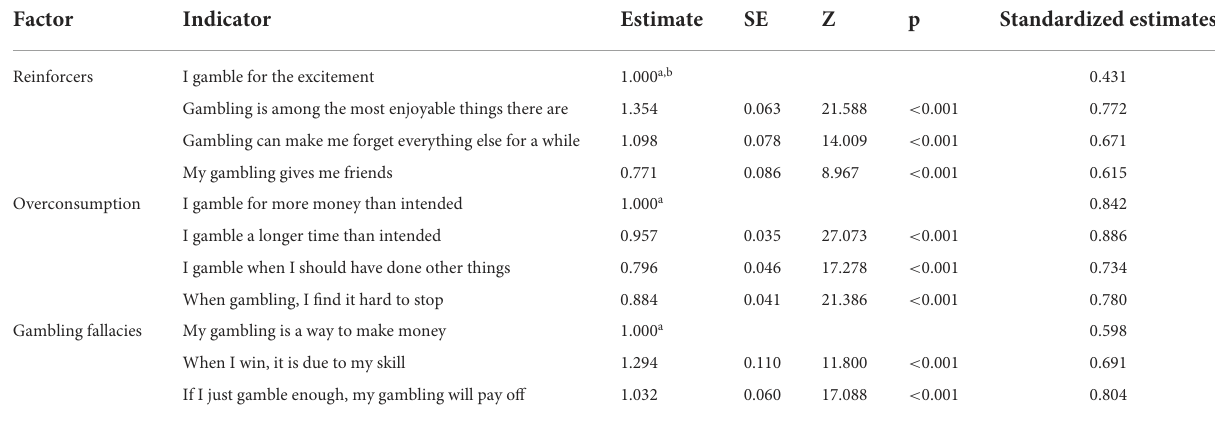
TABLE 1 Factor loadings of the Jonsson-Abbott Scale. Factor Indicator Estimate SE Z p Standardized estimates